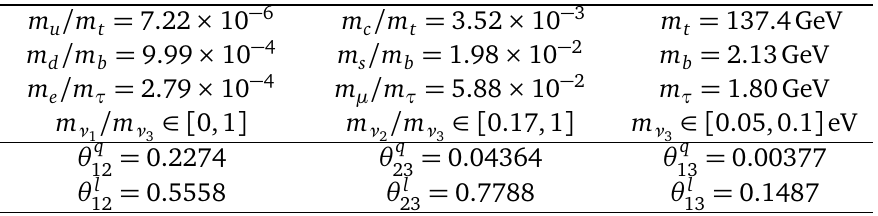
Table 1: Quark and lepton masses and mixing angles at 10 TeV. The charged fermion masses and quark mixing angles are taken from [ 27 ] while neutrino masses and lepton mixing angles are derived from [ 28 ] assuming normal ordering in the neutrino masses. / m = 7.22 × 10 − m u t